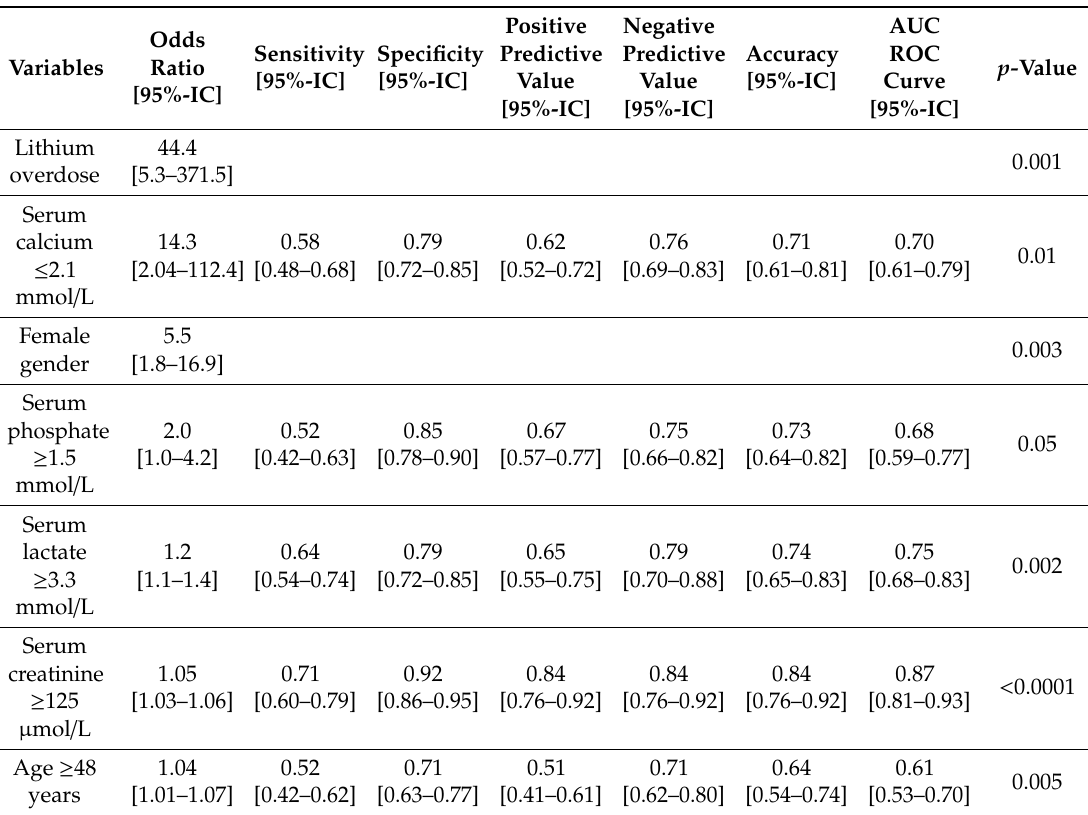
Table 5. Variables on intensive care unit admission significantly associated with the risk of acute kidney injury in the poisoned patient with rhabdomyolysis based on a multivariate logistic regression analysis.